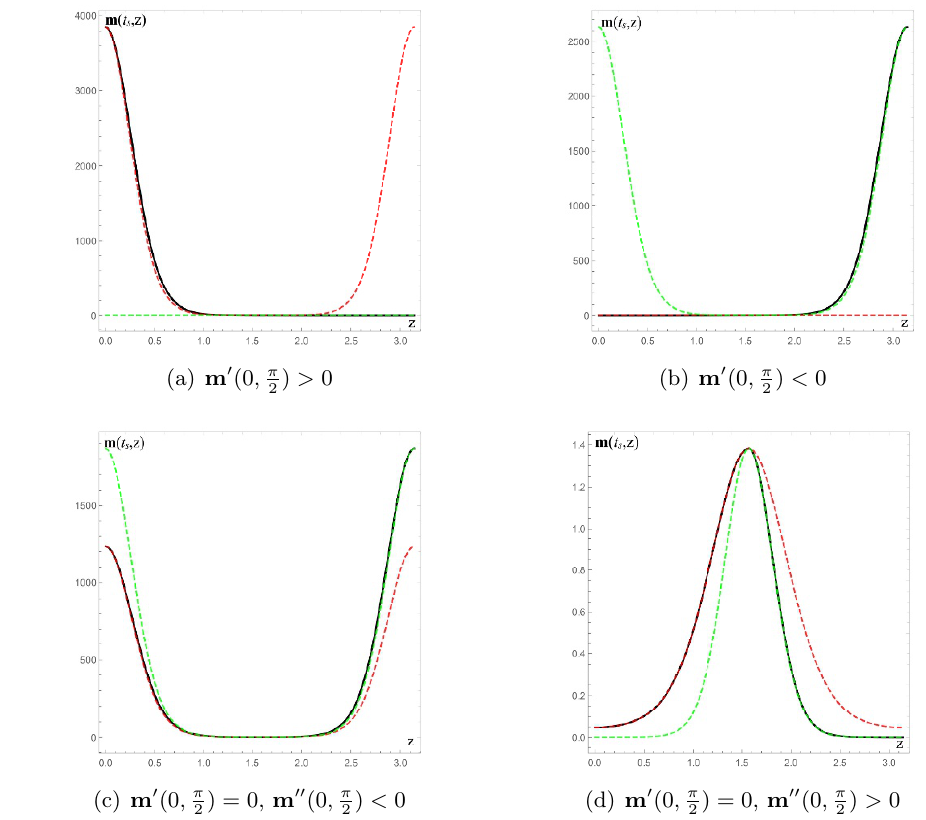
Figure 4 . The snap shots of the possible con(cid:12)gurations of the unstable RN-dS black holes at some given instance t s . Panel (a) describes the con(cid:12)guration that the mass density locates mainly at the north pole, i.e. z = 0. Similarly, in panel (b) the mass density locates mainly at the south pole, i.e. z = (cid:25) . In panel (c) almost the mass density occupy near both poles, so resembles a double spots. In panel (d) the mass density focuses on the equator, i.e. z = (cid:25)= 2, so is complementary for panel (c). Note that the red and green lines are (cid:12)tted lines with m ( t; z ) = (1 + Q 2 ) exp( ae !t cos 2 z ) in which the parameter a can be di(cid:11)erent on the two